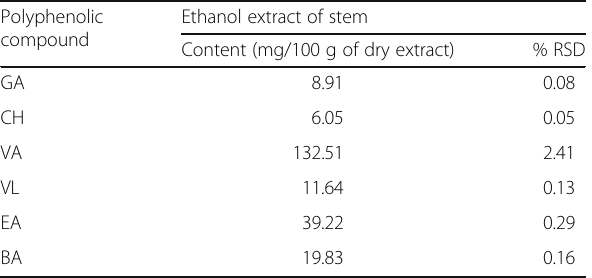
Table 4 Effect of leaf and stem extract on the latent period and of mean stool count of castor oil induced diarrhoeal episode in